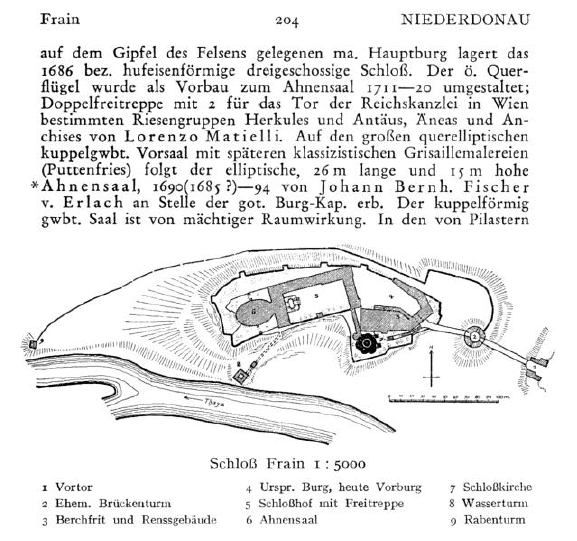
Figure 8. Example of the Dehio Handbook from 1941: Combination between descriptive text and site-plan with index of the parts of the ensemble and visualization of the